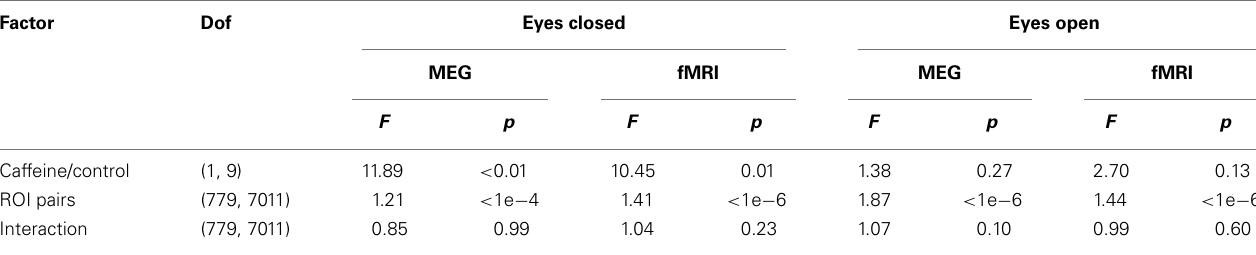
Table 1 | Quantitative assessment of the group data for both modalities (fMRI and wide-band MEG) and both conditions (eyes closed and open) using repeated measures two-way analysis of variance (ANOVA) to examine the effects of (1) caffeine/control and (2) ROI pair on the measured connectivity changes.